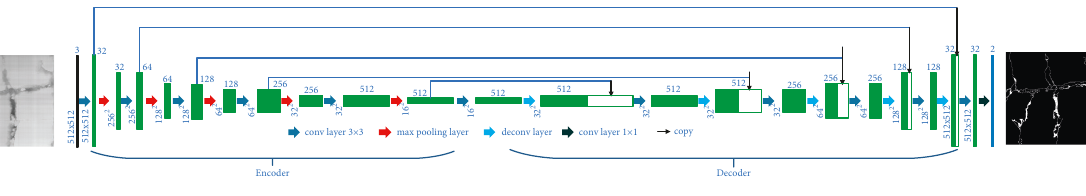
Figure 4: The structure of U-Net.